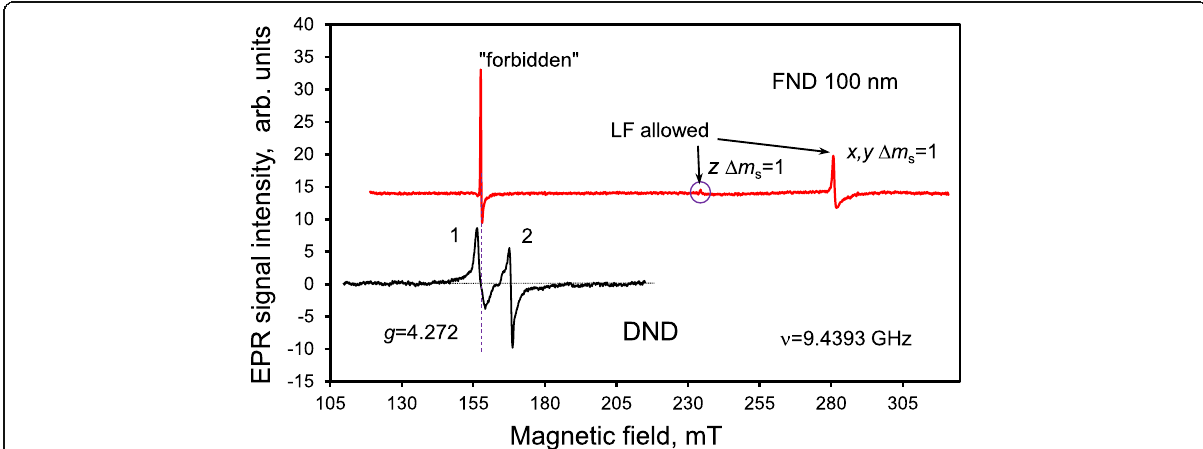
Fig. 2 EPR spectra of acid-purified DNDs in the region of half magnetic field (black curve) and of reference electron-irradiated fluorescent Ib HPHT diamond nanoparticles with mean size ~100nm (red curve) in the range up to 320 mT. Both lines of the DND EPR spectrum are marked by numbers 1 and 2. The low-field line 1 with g =4.272 corresponds to NV − centres. Lines related with low-field (LF) allowed z Δ m s =1 and x , y Δ m s =1 transitions in FND 100nm are marked by arrows for the upper spectrum. The weakest, barely distinguishable line related with allowed z Δ m s =1 transition is additionally marked by a circle. The microwave frequency was 9.4393GHz